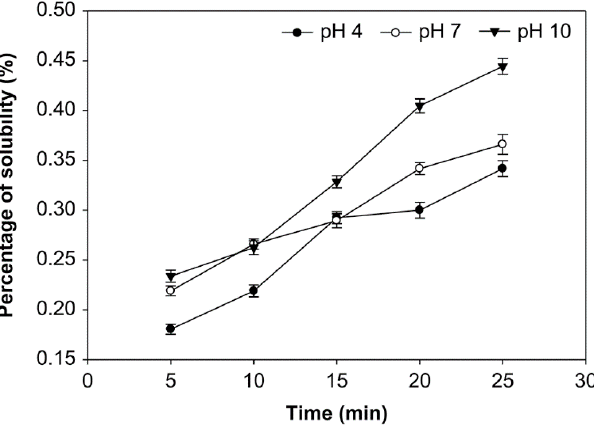
Figure 8. The effect of time on solubility at various pH with the starch concentration of 20% ( v / w ).